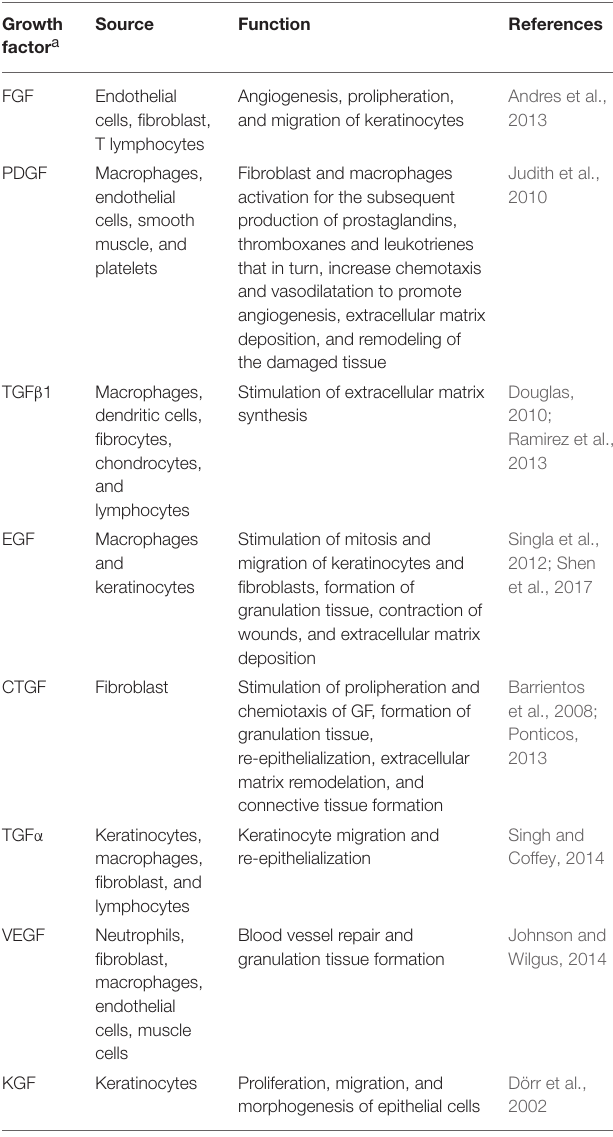
TABLE 1 | Source and function of growth factor involved in repair of the skin. Growth factor